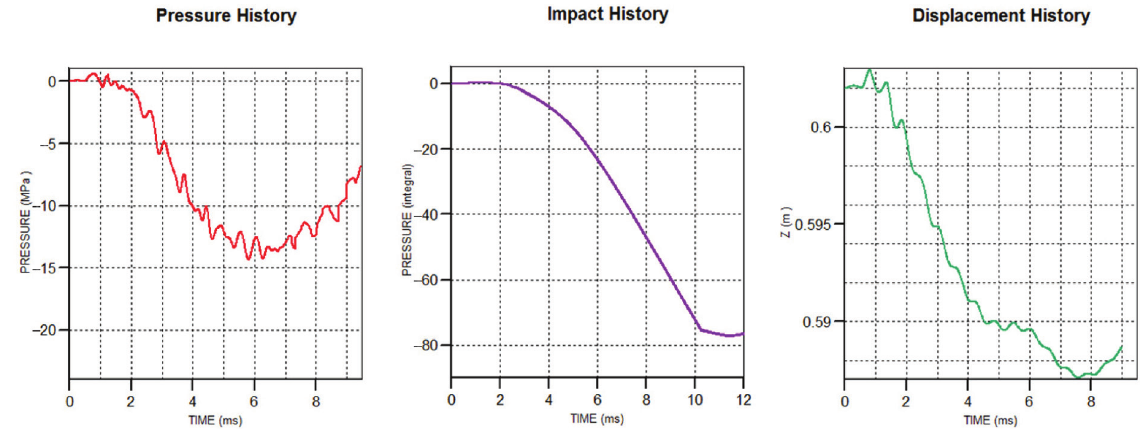
Fig. 7. Time history graphs of pressure, impact and maximum displacement in one-layer laminated glass